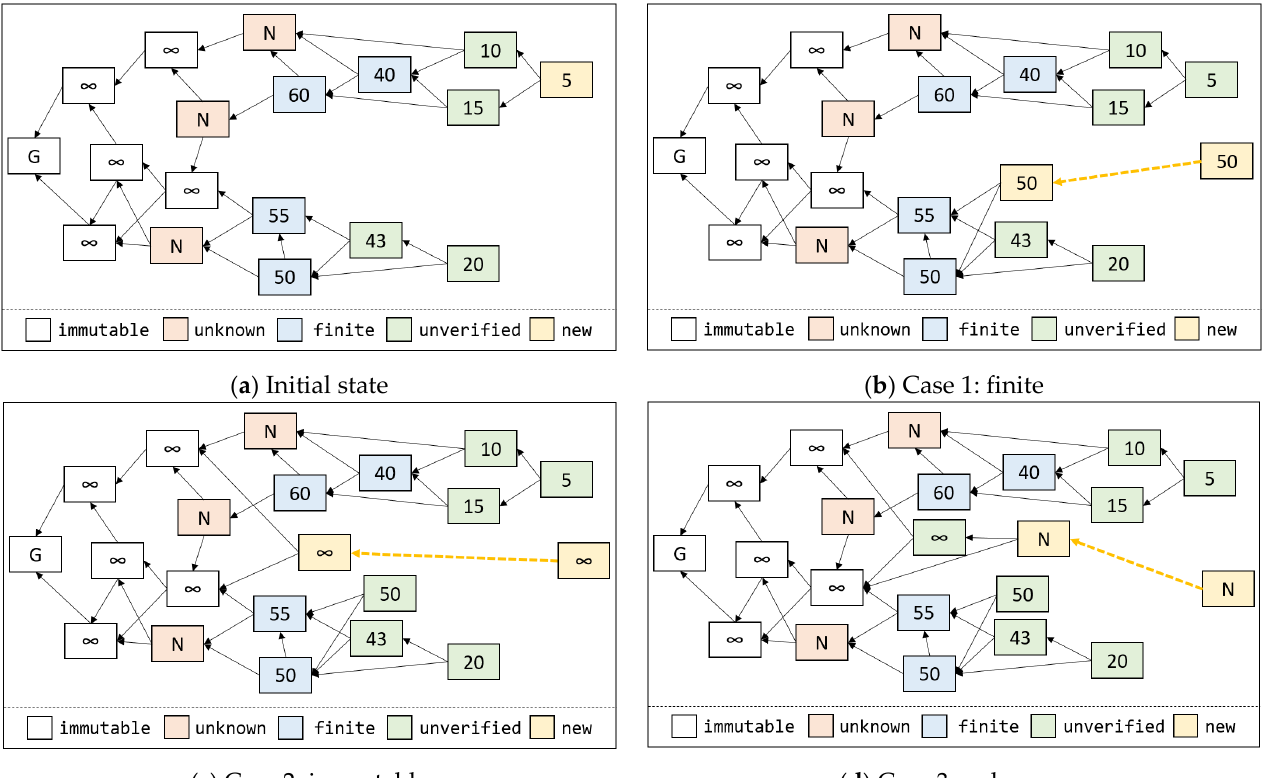
Figure 3. Climb-up write cases in